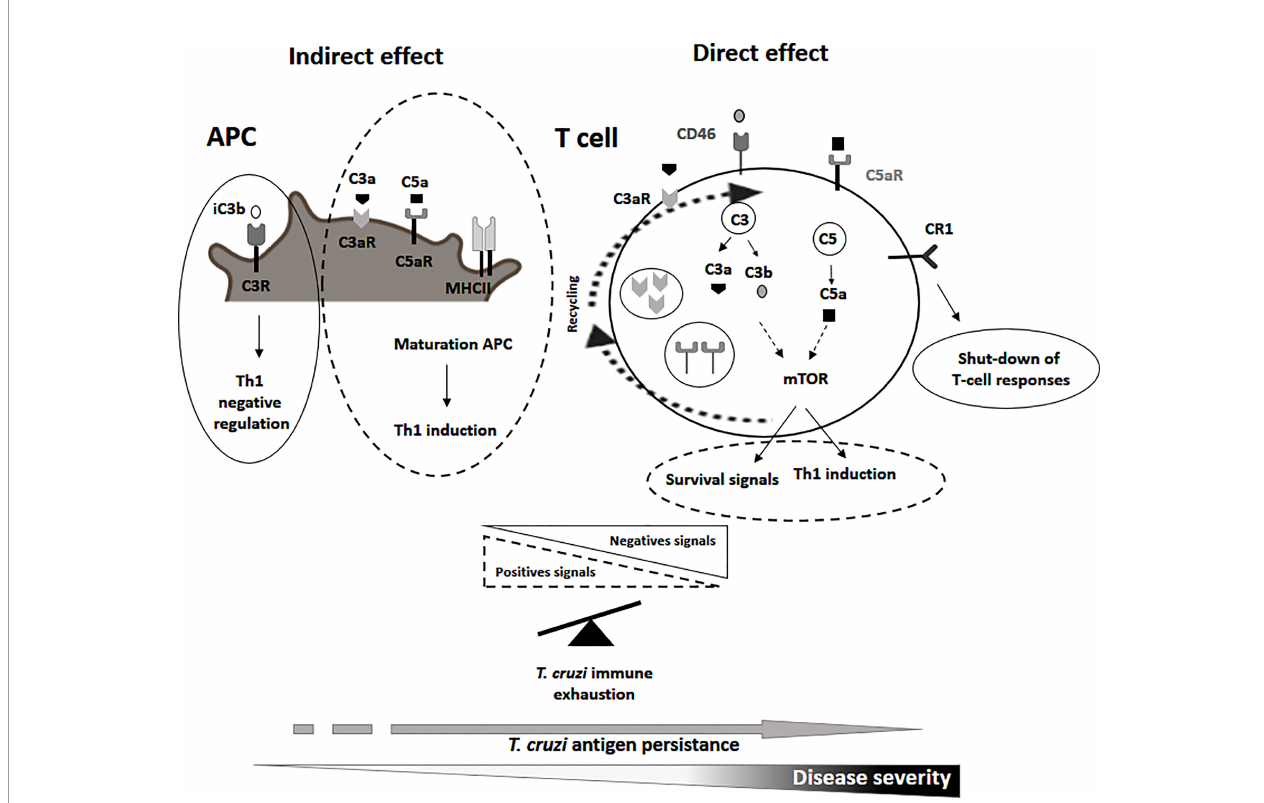
FIGURE 1 | Representative scheme of the non canonical functions of the complement molecules in the putative roles on T-cell immune exhaustion during chronic human T. cruzi infection. Possible roles of the C3a, C3b, C5a, their receptors and complement receptor 1 and CD46 in T-cell exhaustion process are indicated. Dashed lines indicate positive signals involved in the maturation of APC, induction of a Th1 response or T-cell survival. Complete lines indicate negative signals involved in the control of a Th1